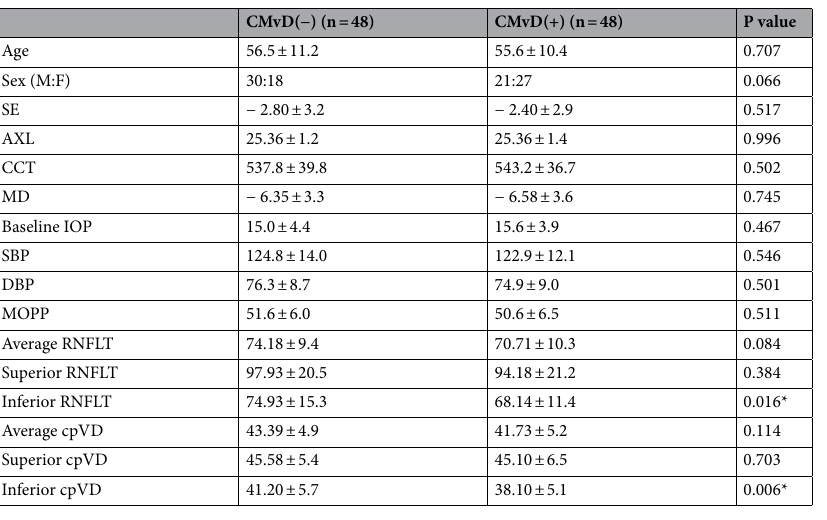
Table 1. Clinical demographics of study eyes with open-angle glaucoma with (+) or without (−) choroidal microvasculature dropout (CMvD). Data are reported as a mean ± standard deviation. CMvD choroidal microvasculature dropout, M male, F female, AXL axial length, MD mean deviation, IOP intraocular pressure, SBP systolic blood pressure, DBP diastolic blood pressure, MOPP mean ocular perfusion pressure, RNFLT retinal nerve fiber layer thickness, cpVD circumpapillary vessel density, ONH VD optic nerve head vessel density, pCVD parapapillary choroidal vessel density, ONH-MvD optic nerve head microvasculature dropout. * P < 0.05 by unpaired t-test unless otherwise indicated. **Chi-square